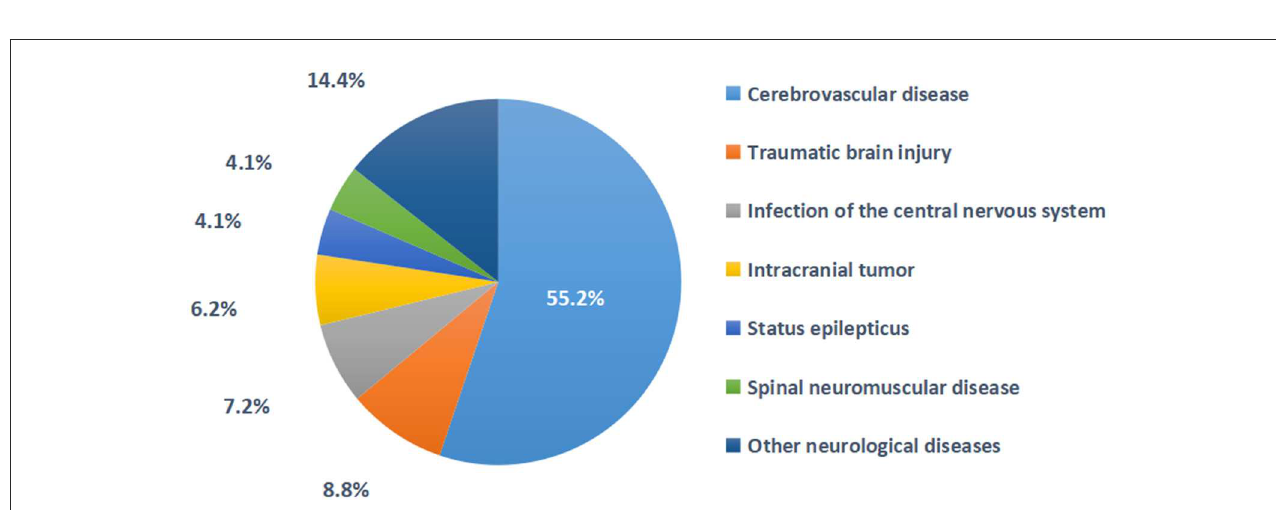
FIGURE2 The proportion of diseases in 165 NCCU patients in 2020. Other neurological diseases include demyelinating disease, metabolic encephalopathy, postcranial/spinal surgery, etc.